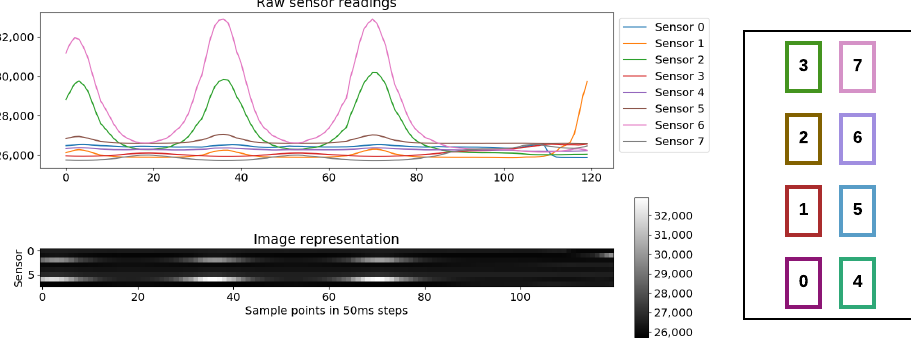
Figure 5. A raw sensory input of 6 seconds length and its corresponding sensor values. The image representation is just another representation of the same information as time series. The sensor numbering is depicted on the